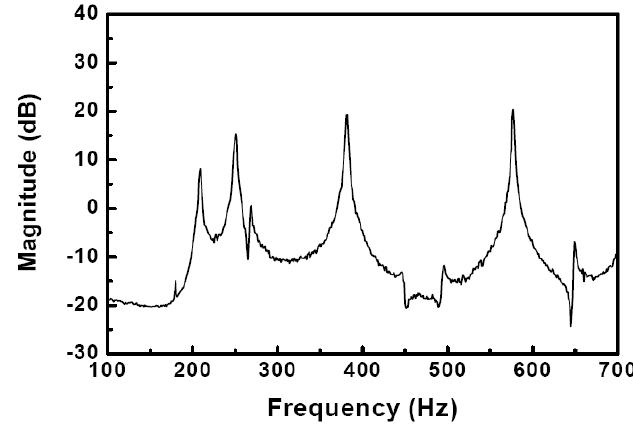
Figure 8. Frequency response of the underwater cylindrical shell structure.